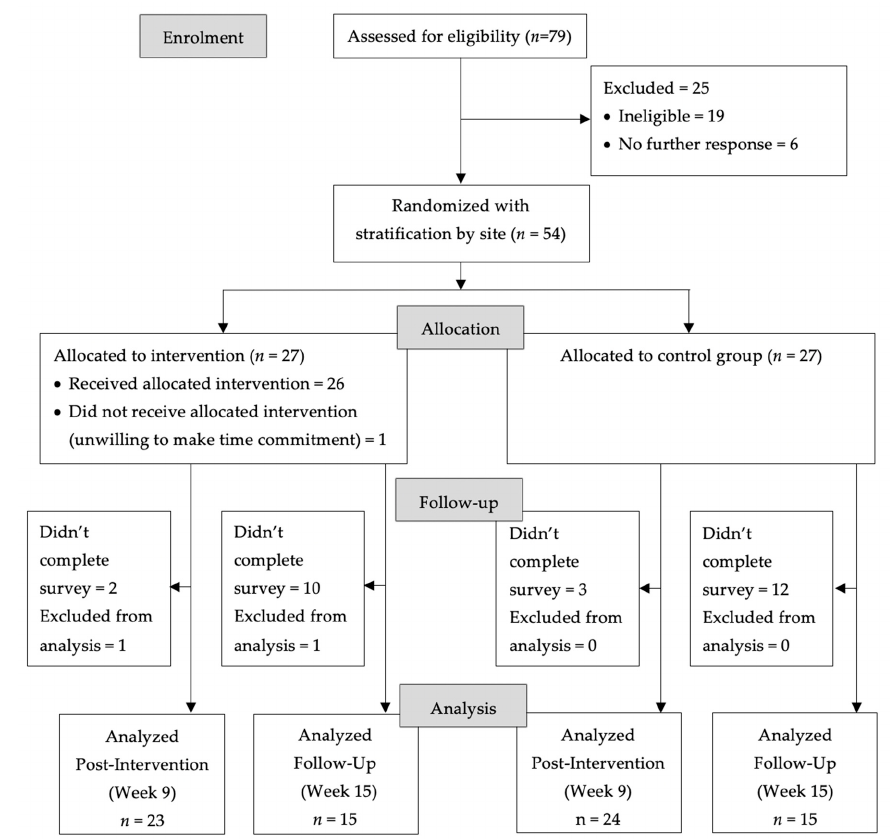
Figure 1. Coping with Cancer in the Kitchen trial flow diagram.